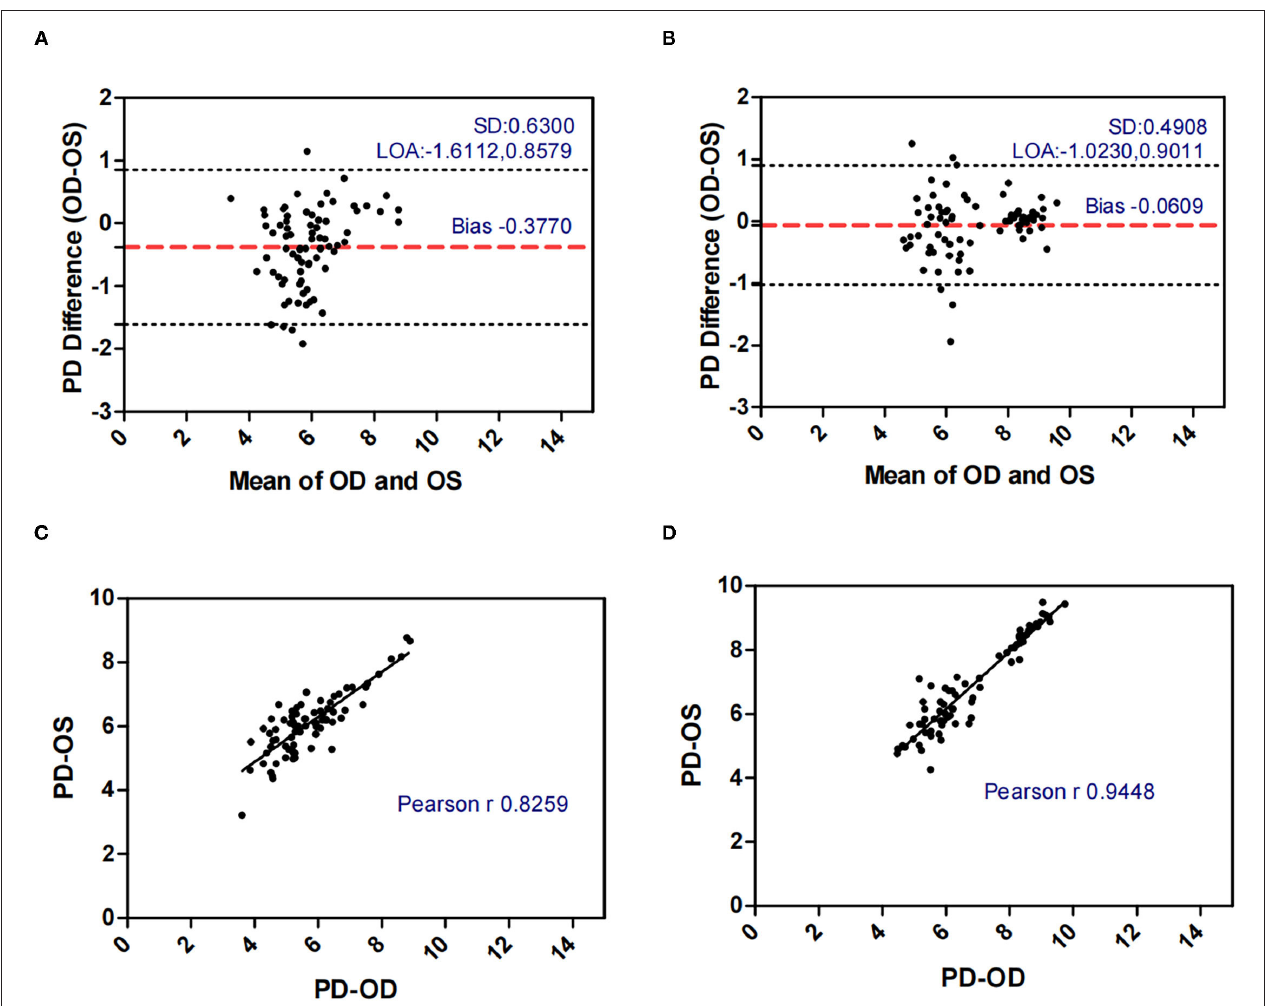
FIGURE 4 | Bland-Altman plots (A,B) and scatter plots (C,D) of PD in concomitant exotropia (A,C) and normal control participants (B,D) of the left and right eyes. OS, left eye; OD, right eye; PD, pupil diameter; LOA, 95% limits of